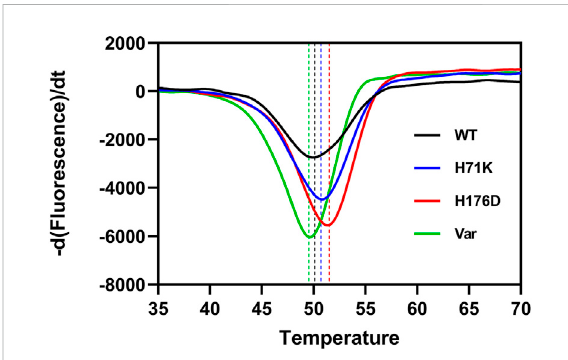
FIGURE 2 Protein thermal shift analysis of Wild-type and mutants. The positions of the black, blue, red and green dashed lines represent the T m values of WT, H71K, H176D, and Var, respectively.